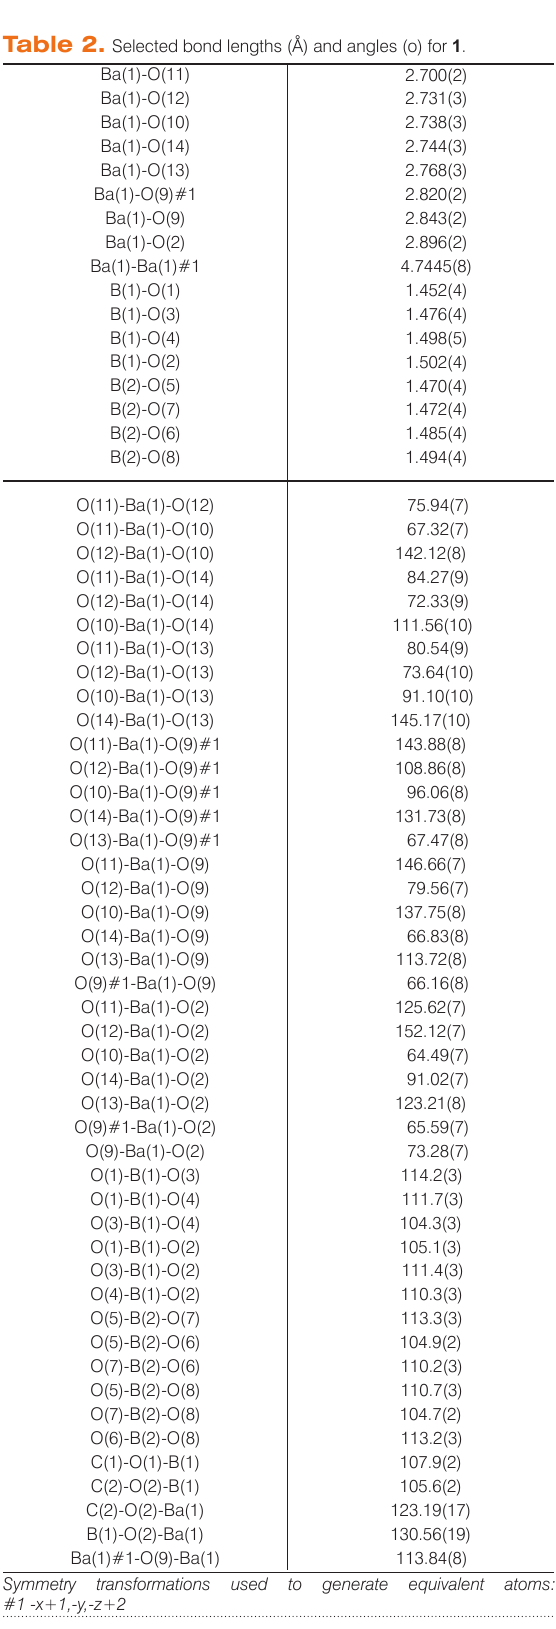
Table 2. Selected bond lengths (Å) and angles (o) for 1